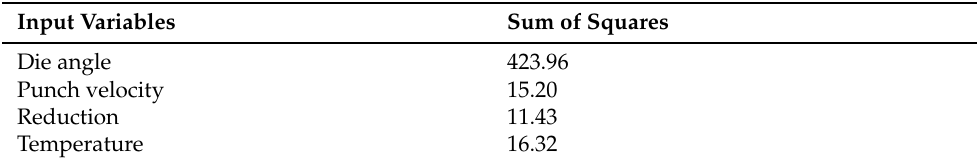
Table 4. The ANOVA